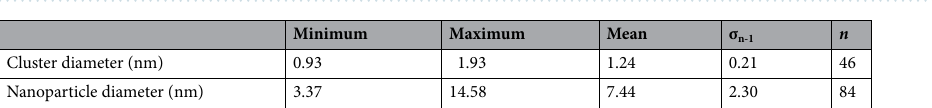
Table 4. Diameter range and statistical information for the Fe-rich clusters and nanoparticles occurring in the surficial amorphous, Fe-rich layer on